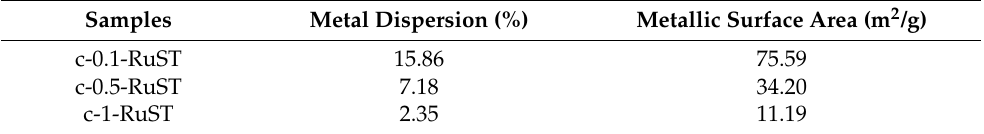
Table 1. CO pulse adsorption experiment results of samples with different RuO x loadings.